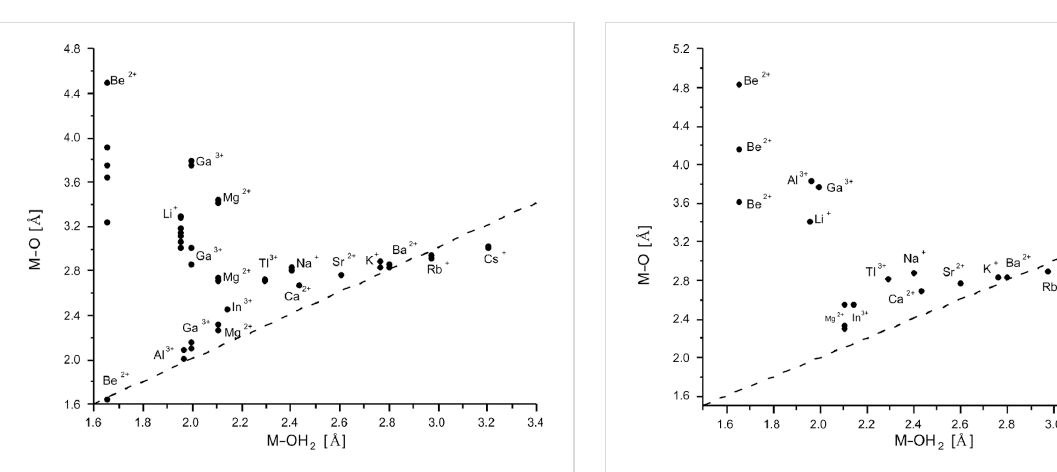
Figure 9: Comparison of the calculated (RB3LYP/LANL2DZp) M–OH 2 and M–O coordinating distances for [2.bpy.bpy] (dashed line: bisecting line; for the data see Table